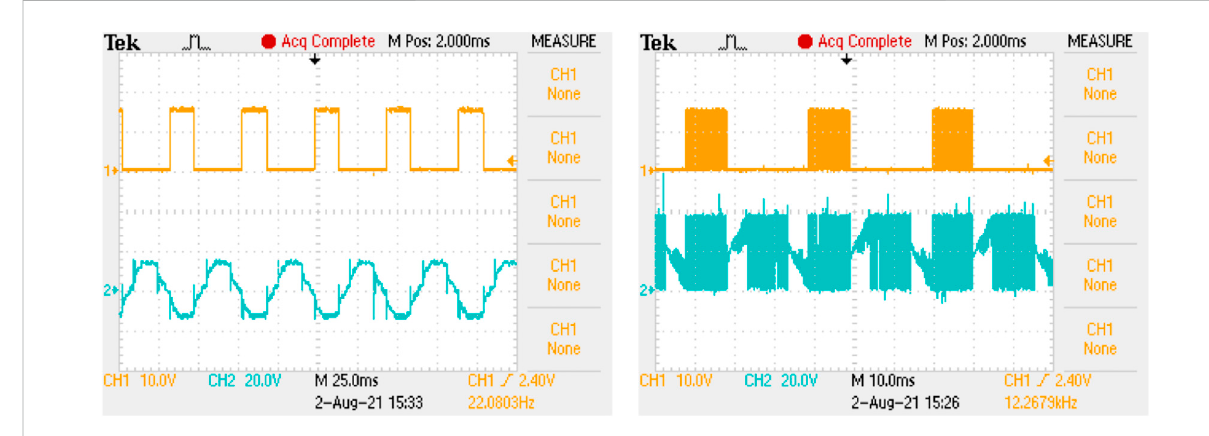
FIGURE 2 Oscillograms showing the control signal of the bridge transistor (left) and the output voltage of the transistor for BLDC motor control with and without PWM